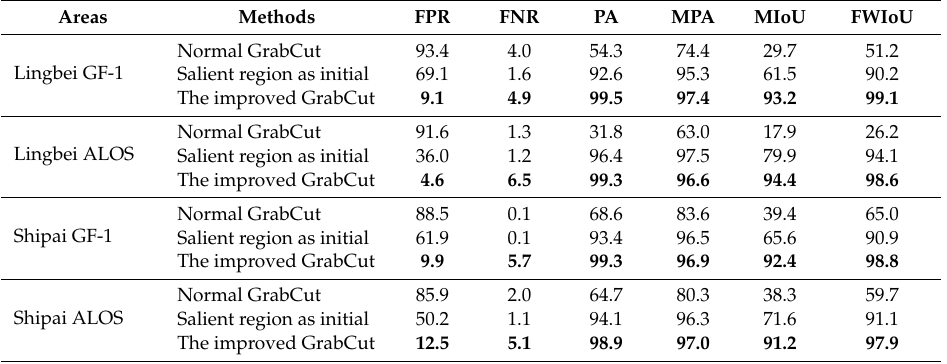
Table 2. Accuracy of REO mining area extraction with various methods in di ff erent study areas.